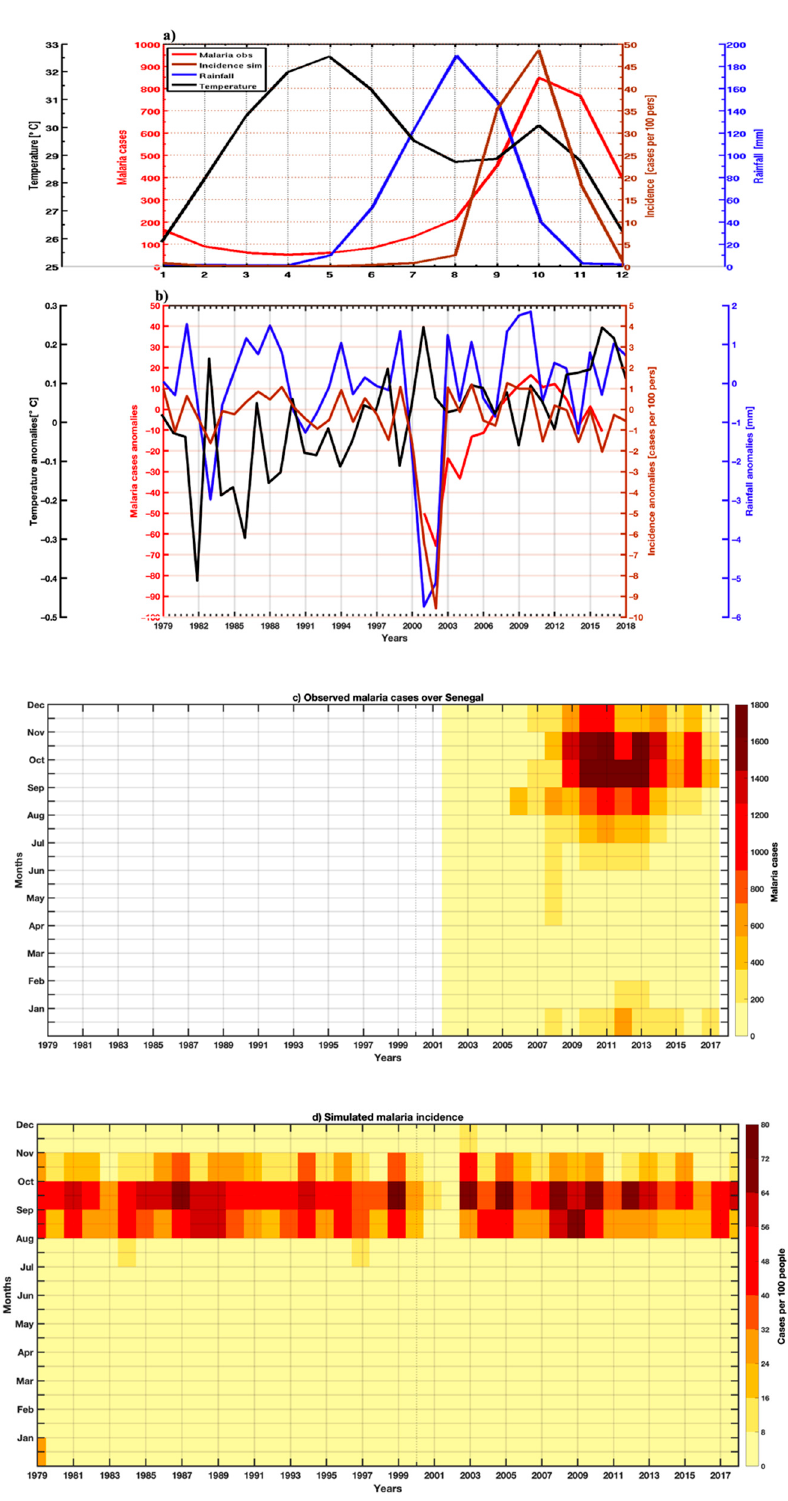
Figure 12. Comparison of the intra- and interannual variability of temperature, rainfall, observed malaria cases, and simulated malaria incidence in Senegal from 2002–2017: ( a ) annual cycles and ( b ) interannual variability; ( c , d ) intra- and interannual variability of malaria cases and simulated malaria incidence in Senegal from 2001–2017.